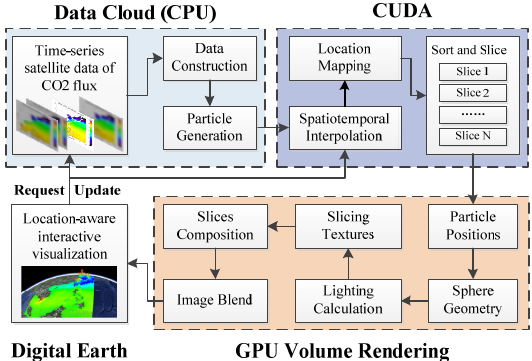
Figure 7. Location-aware interactive volume rendering of CO 2